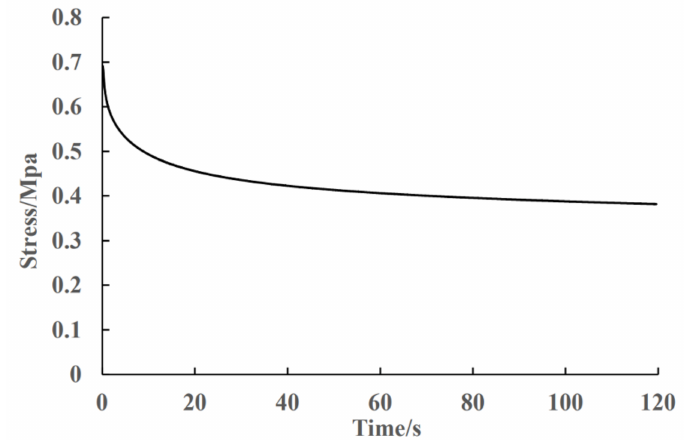
Figure 5. The stress relaxation curve of carrot flesh.